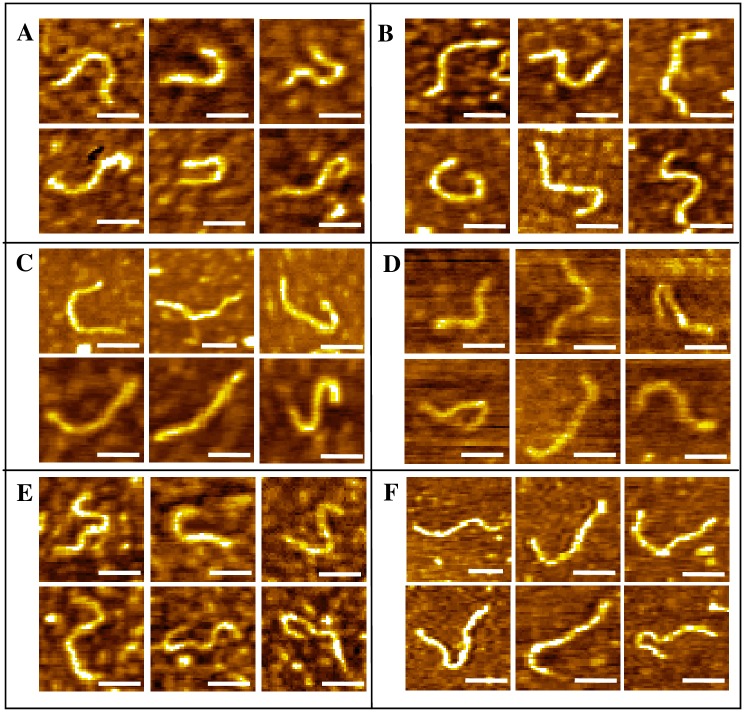
AFM topographs of DNA-nogalamycin complex after incubation for (A) 1 h, (B) 6 h, (C) 12 h, (D) 18 h, (E) 36 h and (F) 48 h.DNAconc: 1.7 μg.ml-1. Scale bar: 100 nm. Z-ranges: (A) 0–0.7 nm, (B) 0–0.8 nm, (C) 0–1.4 nm, (D) 0–0.6 nm, (E) 0–0.8 nm and (F) 0–0.8 nm.